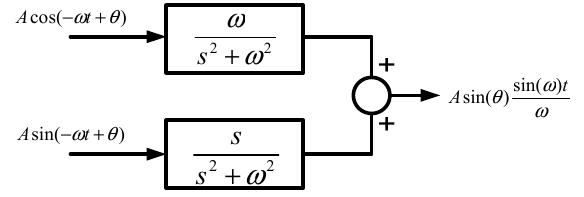
Figure 5. Negative sequence integral equation.